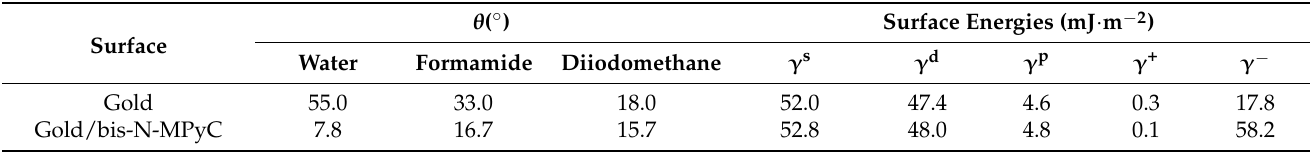
Table 1. Contact angle measurements of gold bare electrode, bis-N-MPyC film modified gold electrodes. Surface